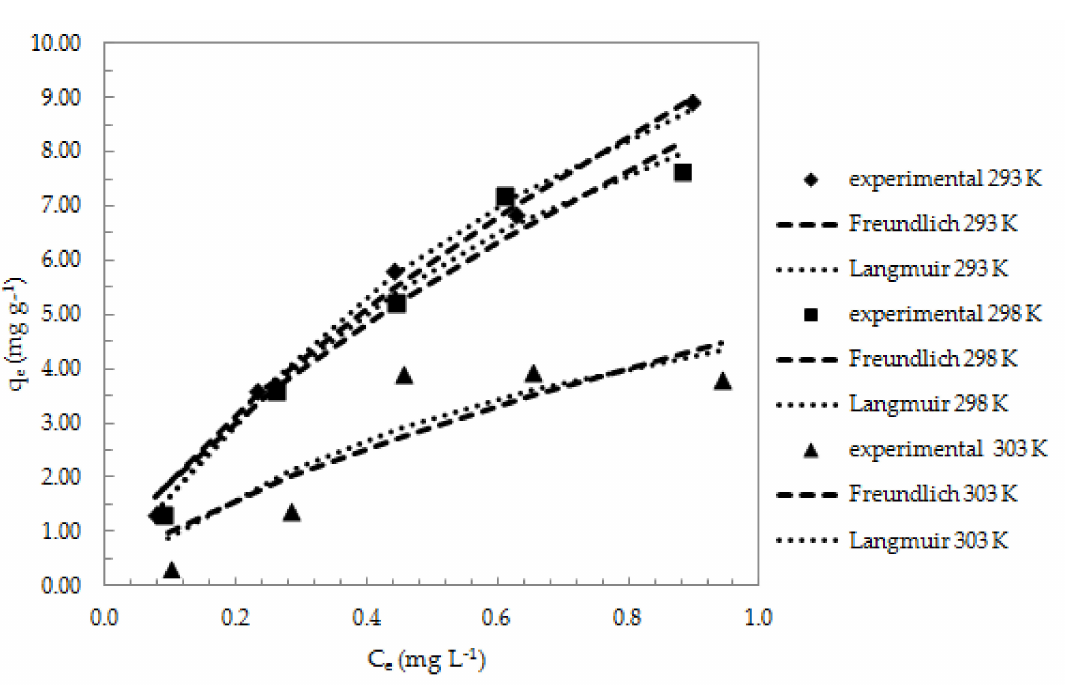
Figure 9. Non-linear Freundlich and Langmuir isotherms of Sb (III) adsorption on ox-xGnP (pH = 7.0, 1 mg L − 1 Sb (III), 1 mg ox-xGnP/100 mL solution, T = 293 K, 298 K, 303 K, contact time 25